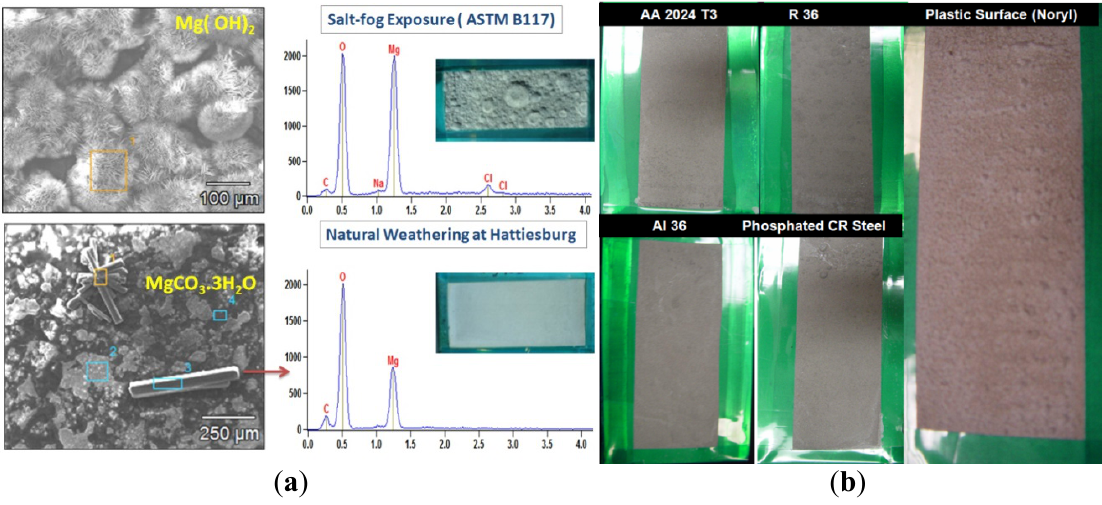
Figure 2. Optical image and a Fourier transform infrared (FTIR) spectroscopy signature of needle-like crystals on Mg cube immersed in 3.5 wt% NaCl saturated with CO MgPUnt primer exposed at Daytona beach for 30 days ( b